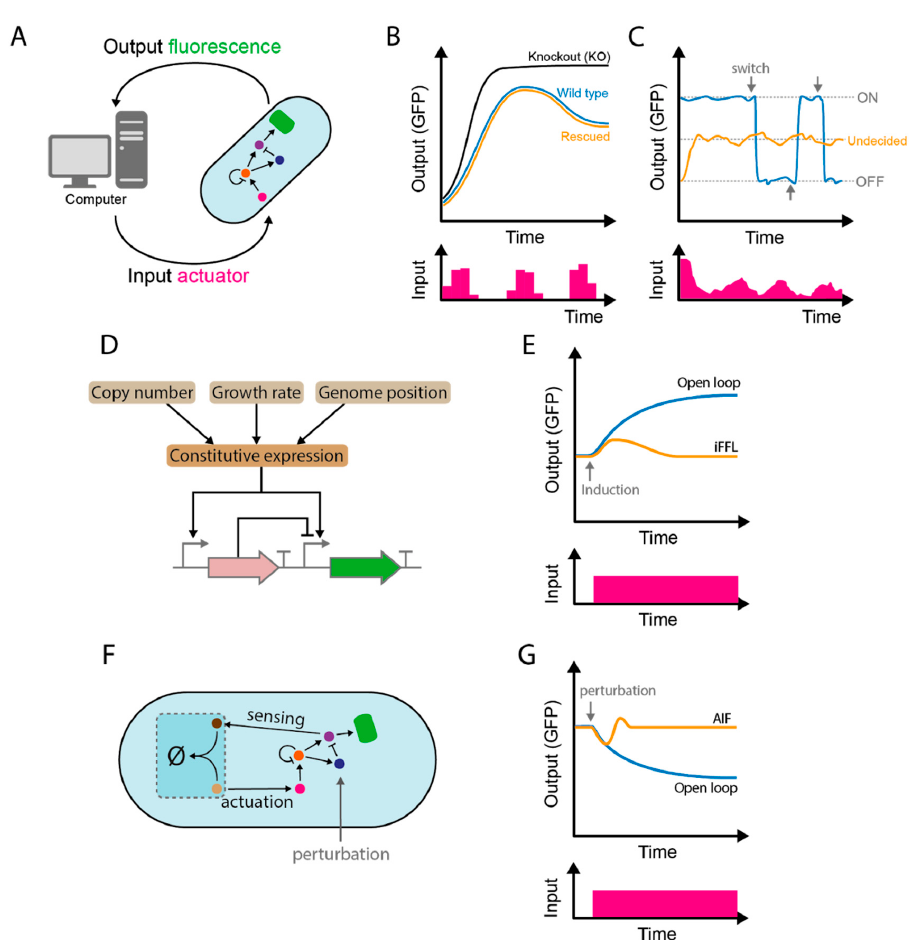
Figure 2. Internal and external control strategies from cybergenetics. ( A ) Computer-aided control. A network of interacting molecular components (circles) with a fluorescent protein output (green) interacts with a computer, which measures and acts on the output by delivering network inputs. ( B ) Dynamic compensation. Native (blue) and negative-feedback knockout (black) outputs for a signaling pathway, compared to computer-controlled negative feedback expression (orange). In this case, regular input pulses (bottom) restored wild-type behavior. ( C ) Application of external control to maintain a bistable system—in this case, a synthetic toggle switch circuit—close to its unstable equilibrium point. The circuit is switched on or off (blue) using two specific chemicals (arrows). By maintaining one input at roughly constant levels (not shown) and adding the other periodically (bottom), the system is maintained at its unstable point and remains undecided (orange). ( D ) Incoherent feed-forward loop (IFFL) based robust constitutive expression. Constitutive expression machinery activates the target gene (green, GFP) and its repressor gene (pink, transcription-activator-like effector (TALE) protein); the repressor gene is encoded upstream in the cassette and binds non-cooperatively to the target gene. Promoters and terminators are represented by right-angled and T-shaped lines, respectively. Sources of perturbations in the capacity for constitutive expression are shown in the upper three boxes. ( E ) Adaptation of output levels to an induced step increase (bottom) in the copy number of the incoherent feed-forward loop cassette (IFFL, orange) and a regular non-feedback system (blue). ( F ) A biomolecular (embedded) antithetic integral feedback controller based on inactivation ( ∅ ) by molecular titration (darker blue square, see text) controls the network, which reports a fluorescent output (as in A). The setpoint is determined by the ratio of the titrated elements (brown and beige circles). ( G ) Robust perfect adaptation of the antithetic integral feedback controller (AIF). Normally, a perturbation (a step function that activates degradation of circuit component; bottom) brings the system to a new steady state (blue). Using the control loop, the system is brought back to its set point